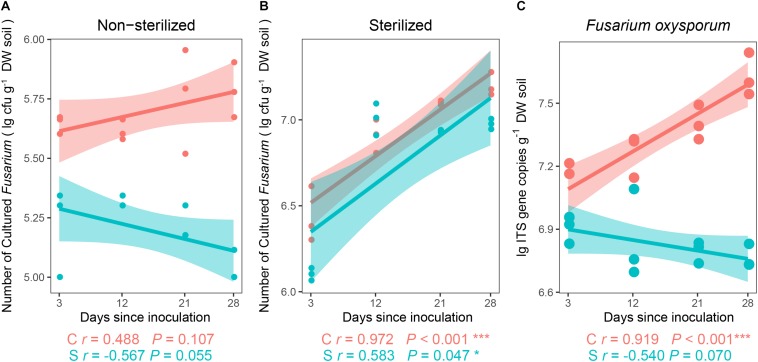
Spearman correlations (r) between target and days since inoculation. Number of cultured Fusarium in (A) non-sterilized treatment, (B) sterilized treatment, and (C) abundance of Fusarium oxysporum in non-sterilized treatments (n = 3). C, red color, disease-conducive soil; S, blue color, disease-suppressive soil. The asterisk denotes a statistically significant Spearman correlation (∗P < 0.05 and ∗∗∗P < 0.001).